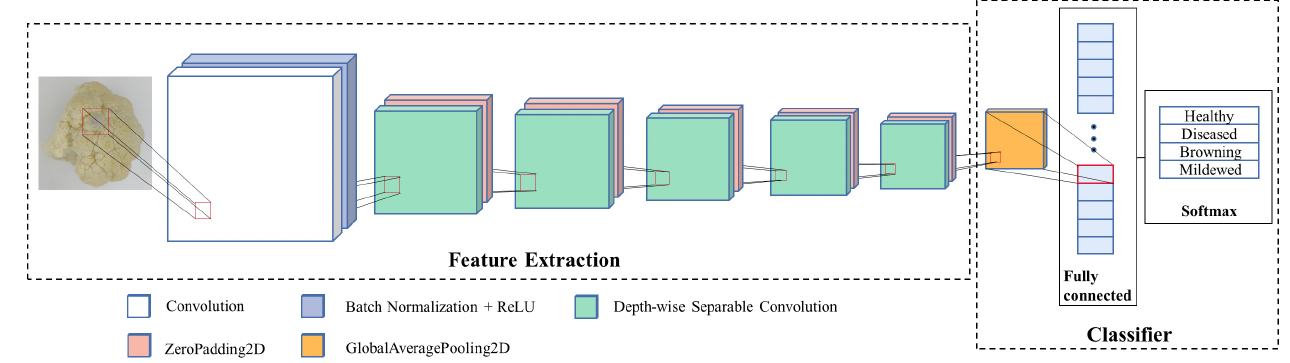
Figure 3. Architecture of MobileNet.